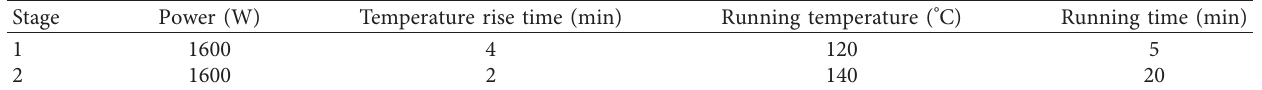
Table 2: Operational parameters of the microwave digestion procedure.